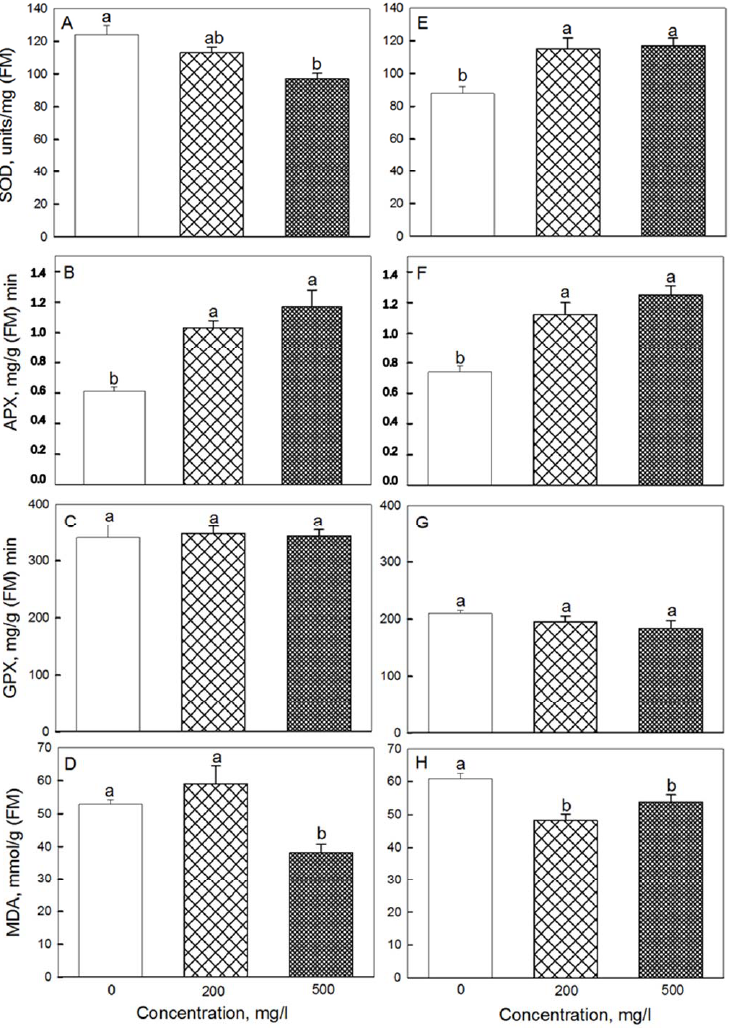
Figure 6. Effects of seed treatment with various concentrations of Fe 3 O 4 nanoparticles on the activity of antioxidant enzymes: SOD ( A , E ) and APX ( B , F ), GPX ( C , G ), as well as MDA content ( D , H ) in ( A – D ) second and ( E – H ) third leaves of 19-day-old wheat plants grown at a light intensity of 300 µ mol (photons) m − 2 · s − 1 . Data are means ± SD ( n = 3). Data labelled with different lower-case letters are significantly different at p <